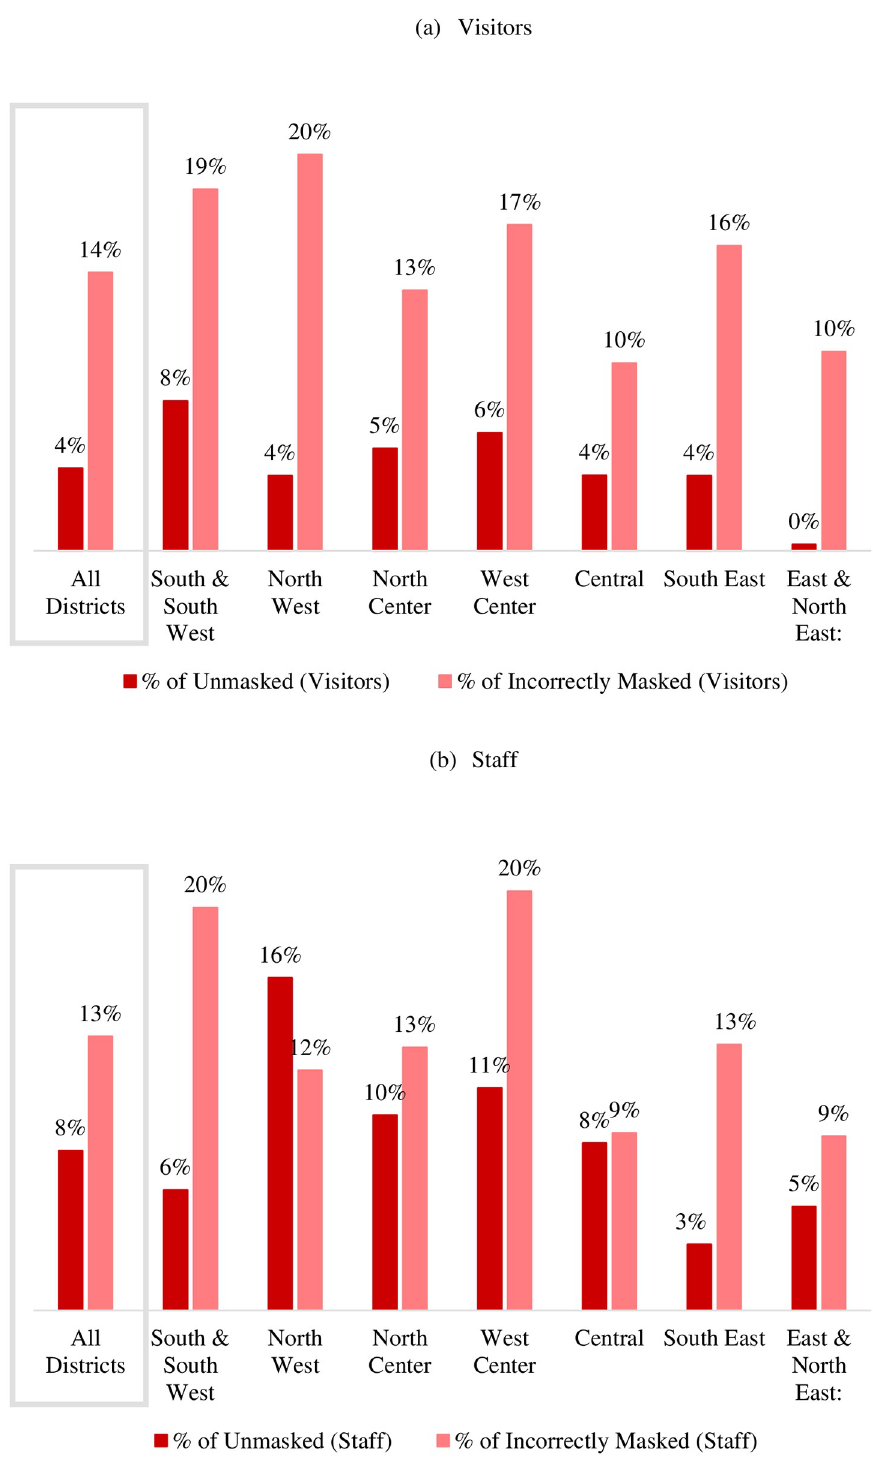
Fig 3. The average prevalence of the unmasked and improperly masked among visitors and staff of Louisville indoor public areas by district, Dec. 14–20, 2020.